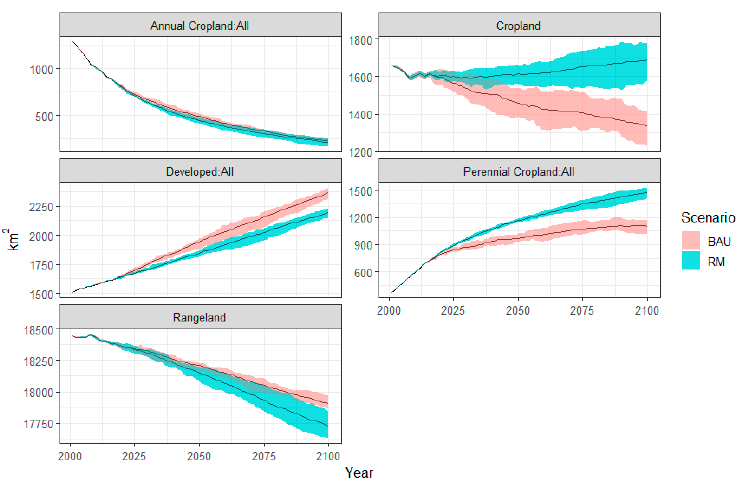
Figure 2. Projected land use and land cover change from 2001–2100 under a business-as-usual (BAU; red) and recent modern (RM; blue) scenarios for the California Central Coast, including Annual Cropland, Cropland (sums Annual Cropland and Perennial Cropland), Developed, Rangeland, and Perennial Cropland. Dark center trendline is the mean for each scenario and shaded area represents the minimum and maximum value ranges across 10 Monte Carlo simulations.